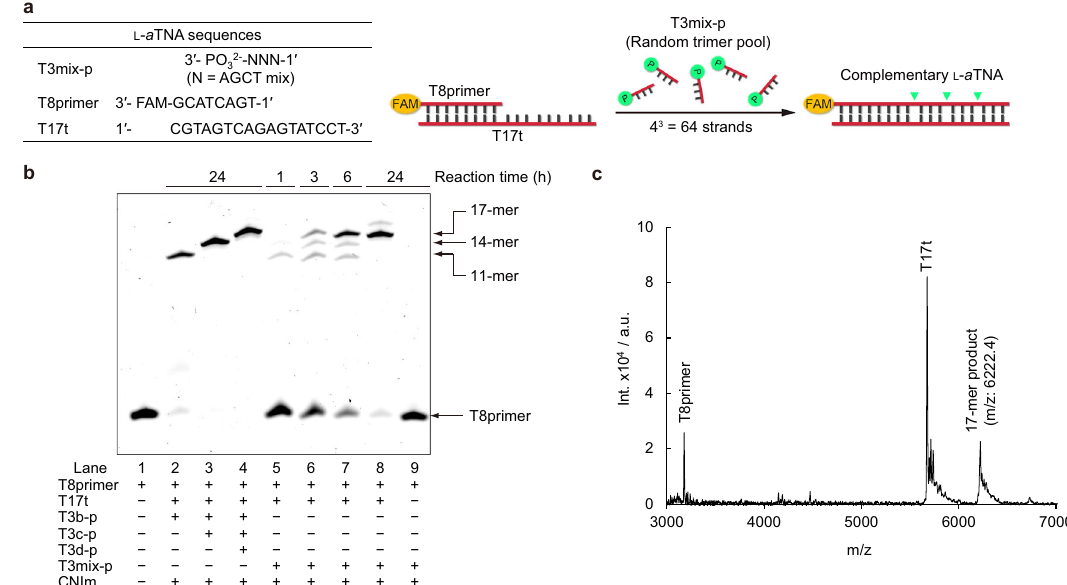
Fig. 5 Template-directed, polymerase-like primer extension from random trimers. a Illustration of primer extension in the presence of T3mix-p pool. b Denaturing PAGE analysis of reaction with randomized trimers. Lane 1, T8primer as a marker; lane 2, reaction with only T3b-p as substrate to yield 11-mer intermediate; lane 3, reaction with T3b-p and T3c-p as substrates to yield 14-mer intermediate; lane 4, reaction with T3b-p, T3c-p, and T3d-p as substrates to yield full-length 17-mer; lane 5, reaction with T3mix-p as substrates after 1 h; lane 6, reaction with T3mix-p as substrates after 3 h; lane 7, reaction with T3mix-p as substrates after 6 h; lane 8, reaction with T3mix-p as substrates after 24 h; and lane 9, control without template. Conditions: [T8primer] = 0.9 μ M, [T3mix-p] = 100 μ M (total), [T17t] = 1.0 μ M, [NaCl] = 100 mM, [MnCl = 20 mM, [CNIm] = 20 mM, 4 °C. Source data are provided as a Source 2 ] Data fi le. c MALDI-TOF MS of reaction with T3mix-p as substrates after 24 h. Source data are provided as a Source Data fi